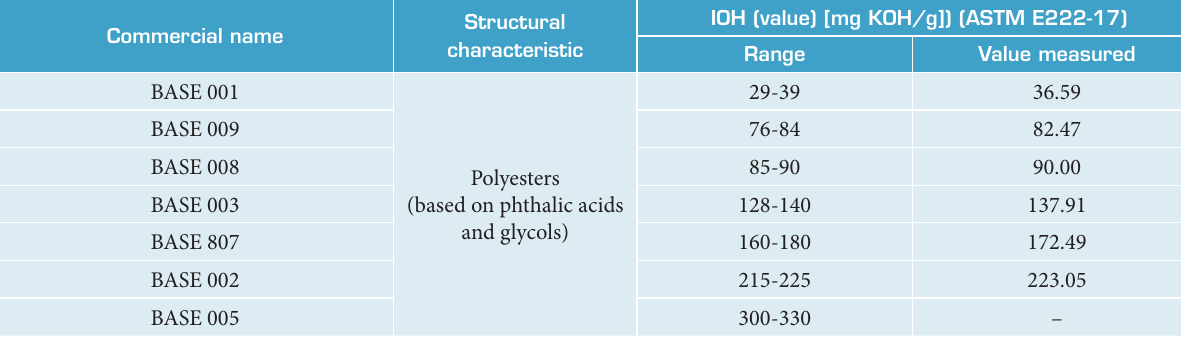
Table 2. Composition and structural characteristics of polyesters and IOH